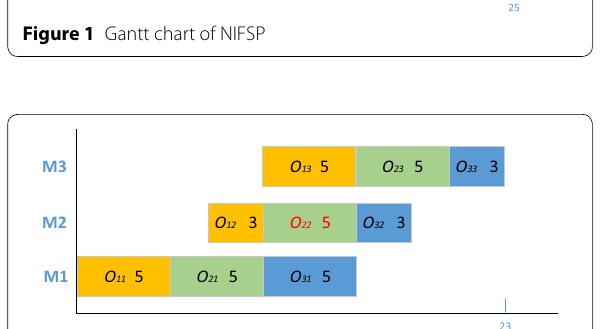
Figure 2 Gantt chart of increasing operation processing